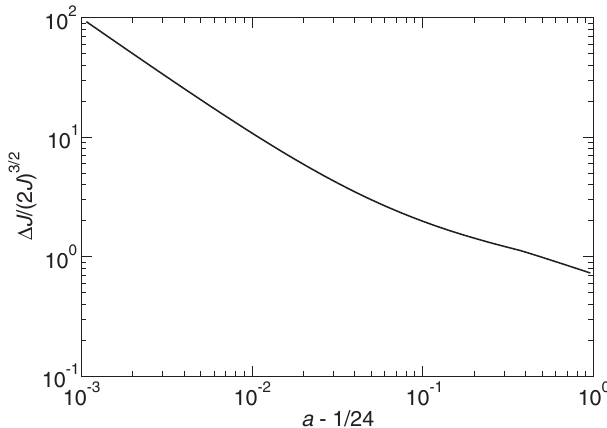
FIG. 7. Distortion of the ellipse, minimized over b and A